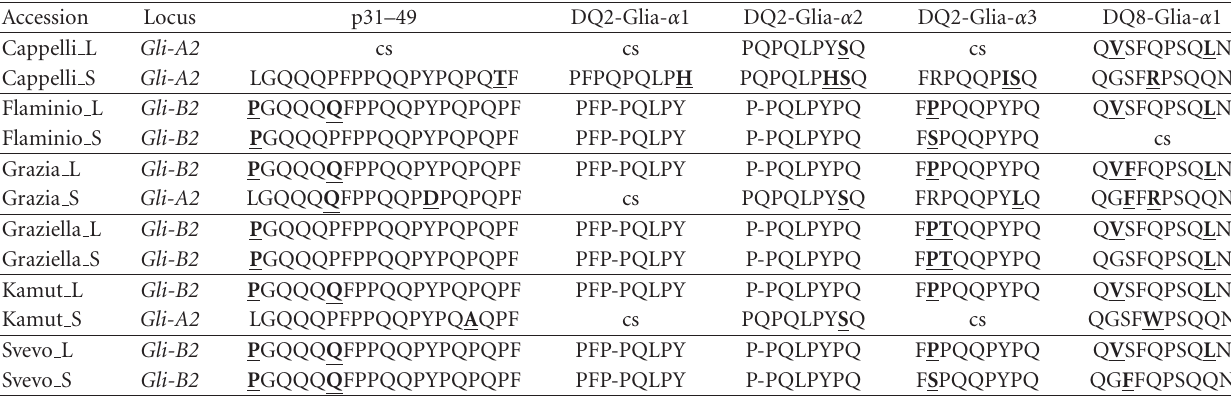
Table 2: p31–49, DQ2-Glia- α 1, DQ2-Glia- α 2, DQ2-Glia- α 3, and DQ8-Glia- α 1 epitopes variants detected in durum wheats under study.